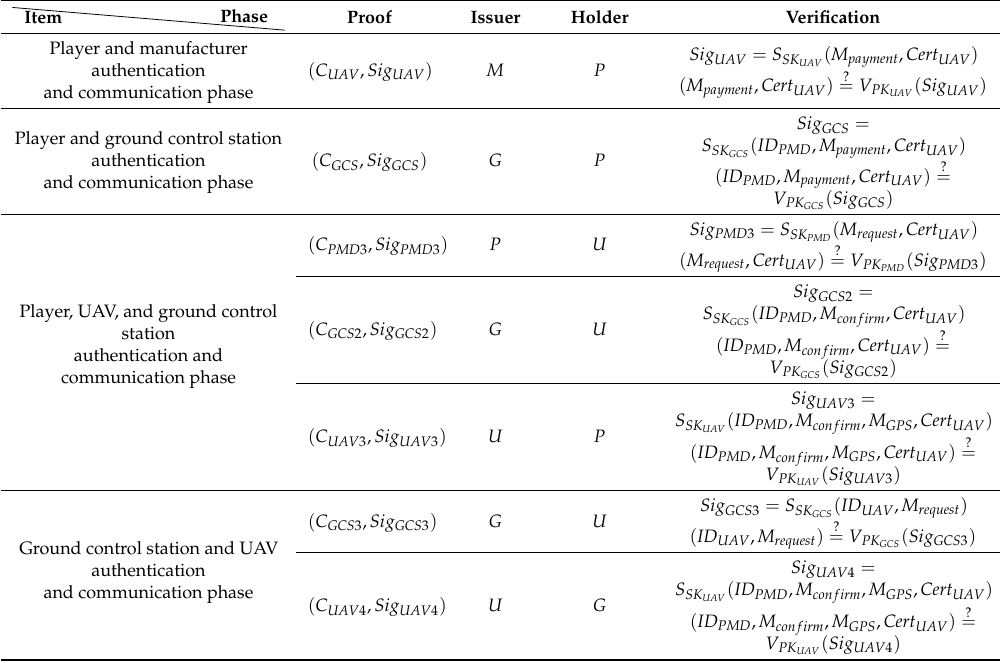
Table 1. Non-repudiation of the proposed